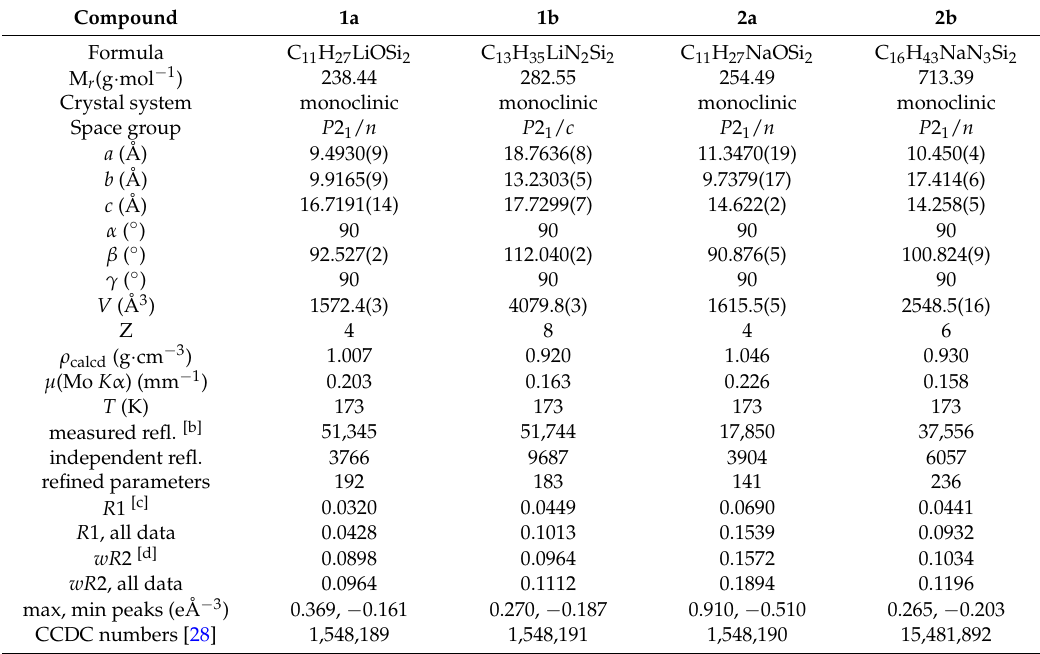
Table 5. Selected crystallographic data for compounds 1a , 1b , 2a and 2b [a]